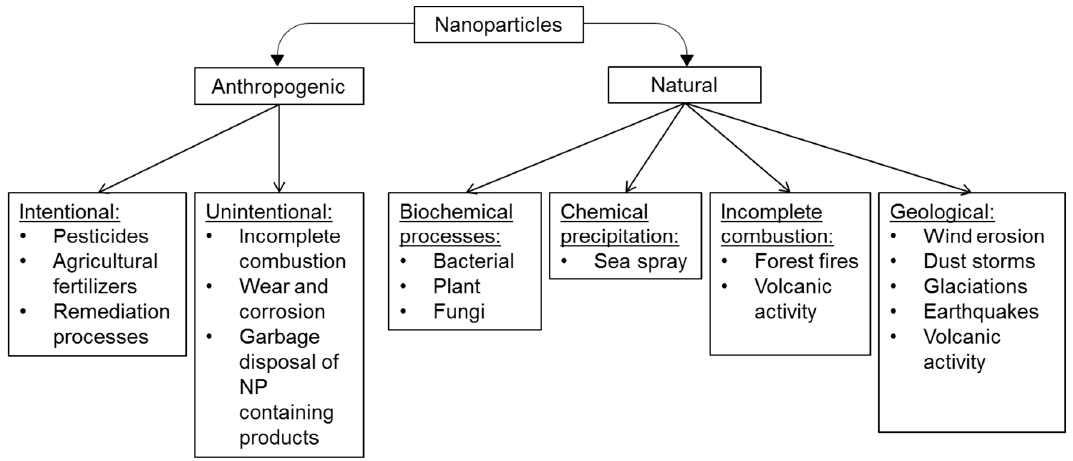
Figure 2. The origin of different nanoparticles according to Buzea és Pacheco [21] with modifications. The abbreviation NP refers to ‘nanoparticle’.